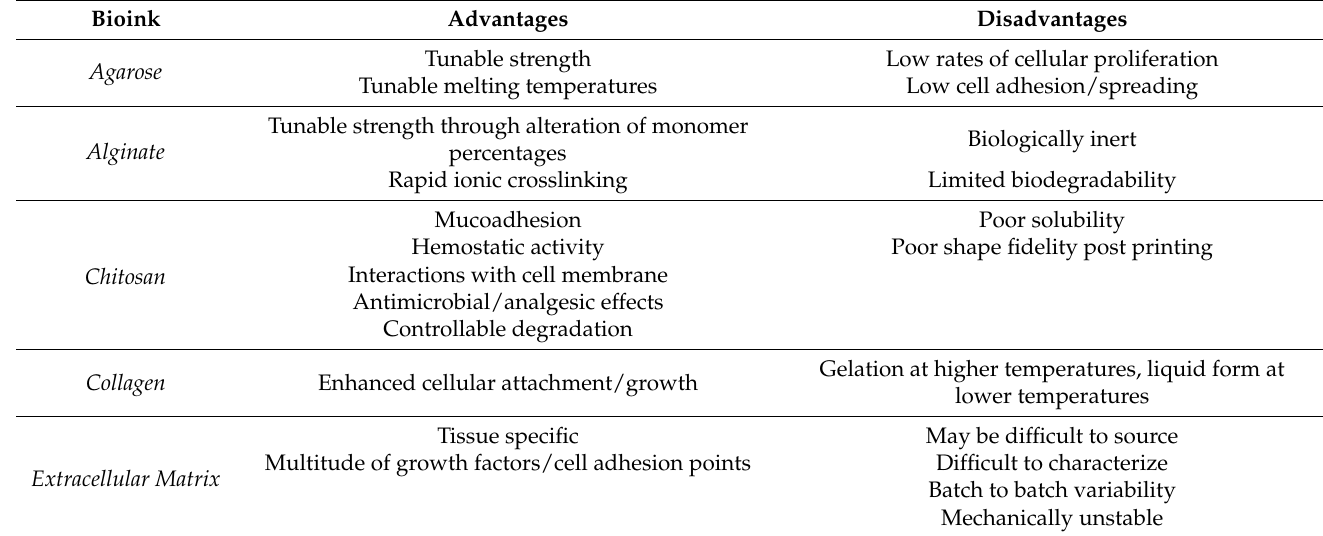
Table 1. Summary of bioinks presented here, with advantages and disadvantages for each bioink. All components are considered in their non-modified (natural)